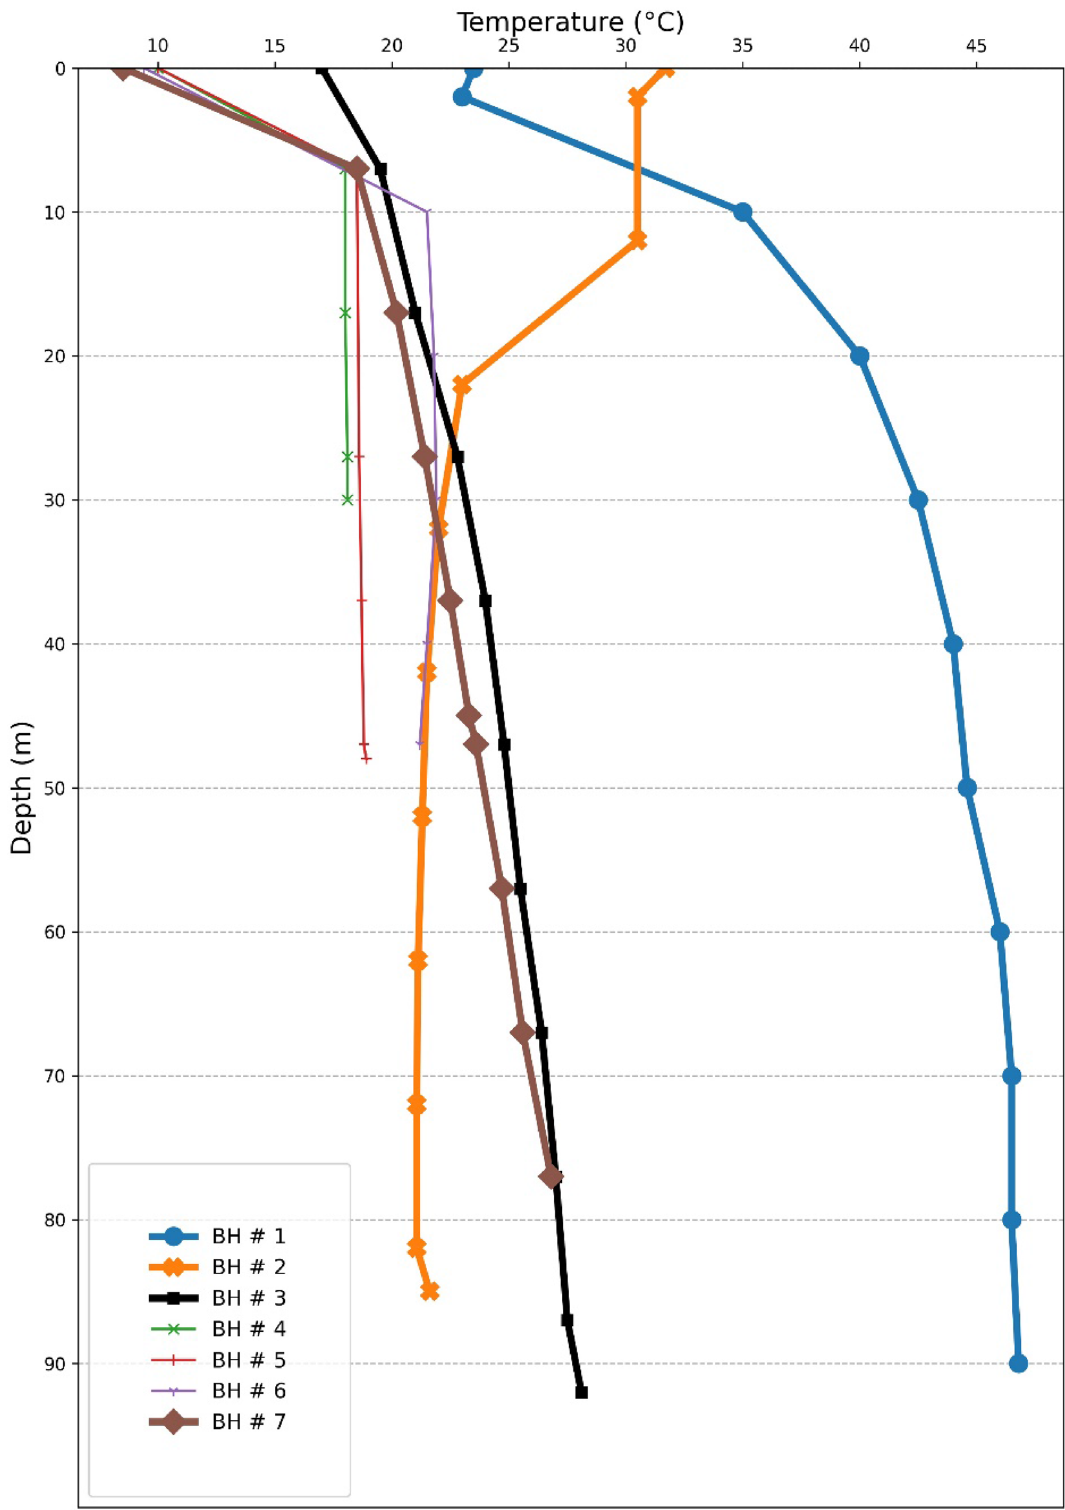
Figure 8. Temperature changes versus depth profile of the